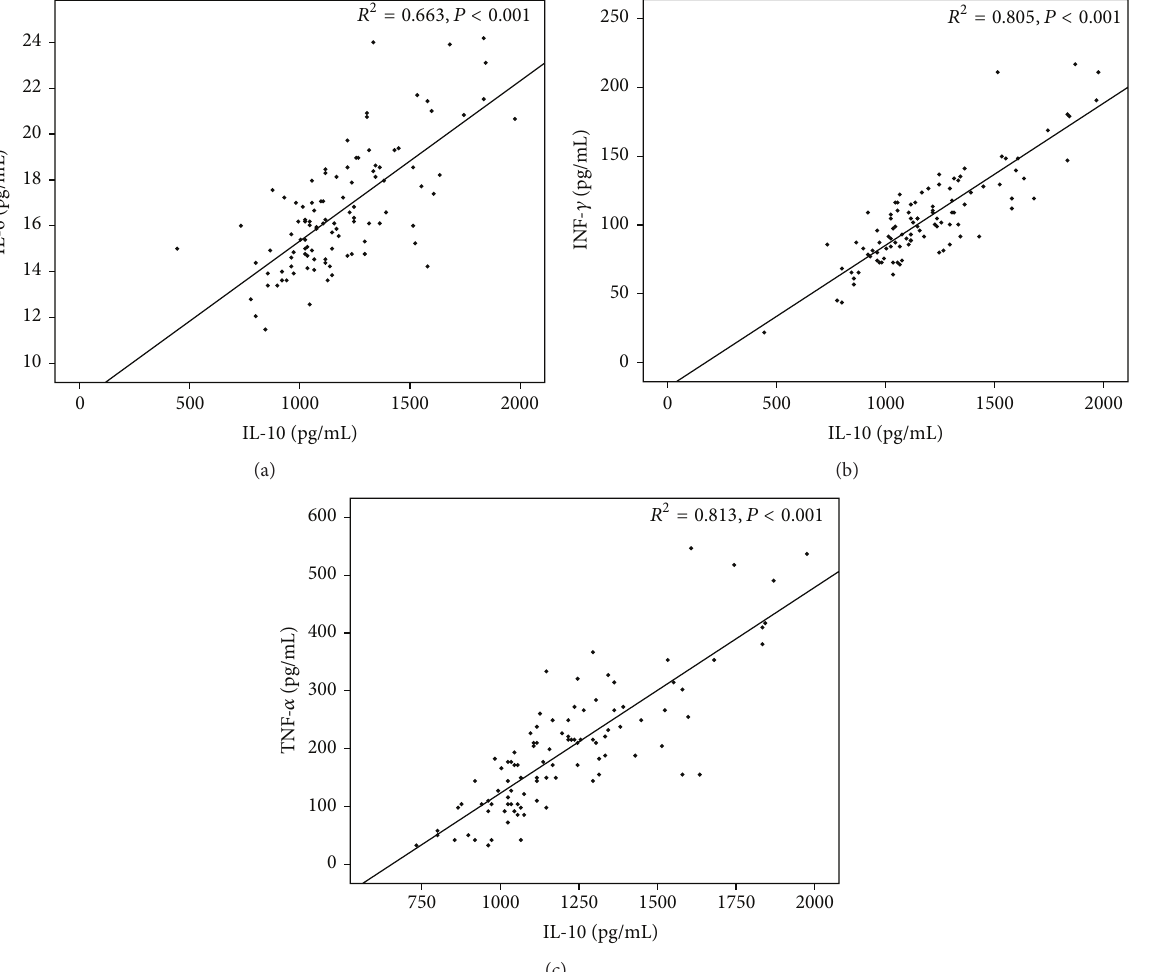
Figure 1: Correlation between IL-6 (a), INF- 𝛾 (b), and TNF- 𝛼 (c) with IL-10 in type 1 diabetic